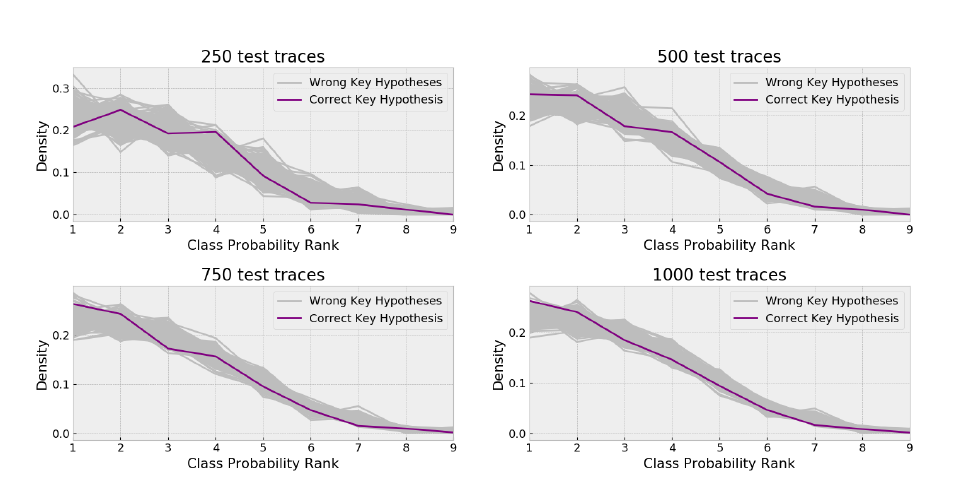
Figure 5: Rank of output class probabilities for the test set by considering correct and incorrect key candidates for different amount of test traces (ASCAD) and